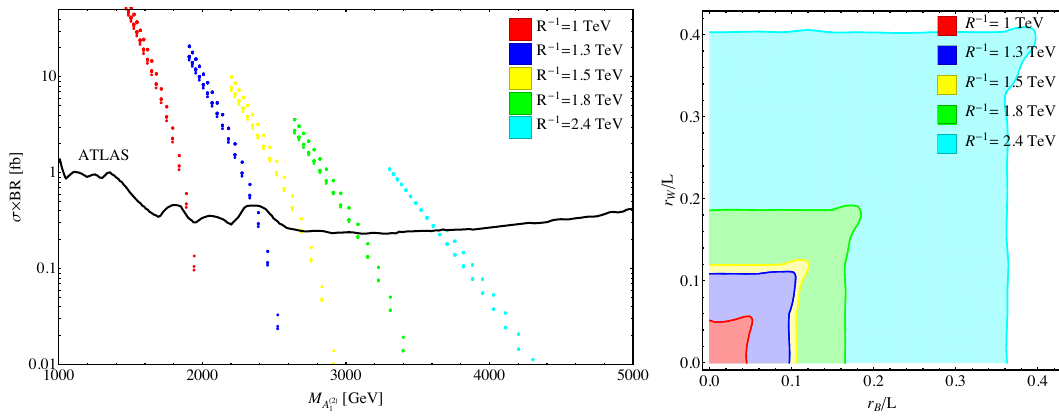
Figure 5 . Constraints from the 13 TeV ATLAS dilepton resonance search with 13.3 fb (cid:0) 1 lumi- nosity [64], and bounds on the NMUED parameter space. Left: constraints on the cross section times branching ratio to two leptons by ATLAS as a function of the resonance mass (black, solid). The model predictions for A (2) (lighter) resonance signals with R (cid:0) 1 = 1 ; 1 : 3 ; 1 : 5 ; 1 : 8 ; 2 : 4 TeV in the 1 parameter window ( r B =L 2 (0 ; 1) ; r W =L 2 (0 ; 1)) are given by scatter plots. Low values of r B =L and r W =L correspond to low cross sections. Right: bounds on the NMUED parameter space from dilepton searches in the r W =L vs. r B =L plane. The red shaded region shows the allowed param- eter space assuming R (cid:0) 1 = 1 TeV. The blue region is for R (cid:0) 1 = 1 : 3 TeV, the yellow region for R (cid:0) 1 = 1 : 5 TeV, the green region for R (cid:0) 1 = 1 : 8 TeV and the larger cyan region is for R (cid:0) 1 = 2 : 4